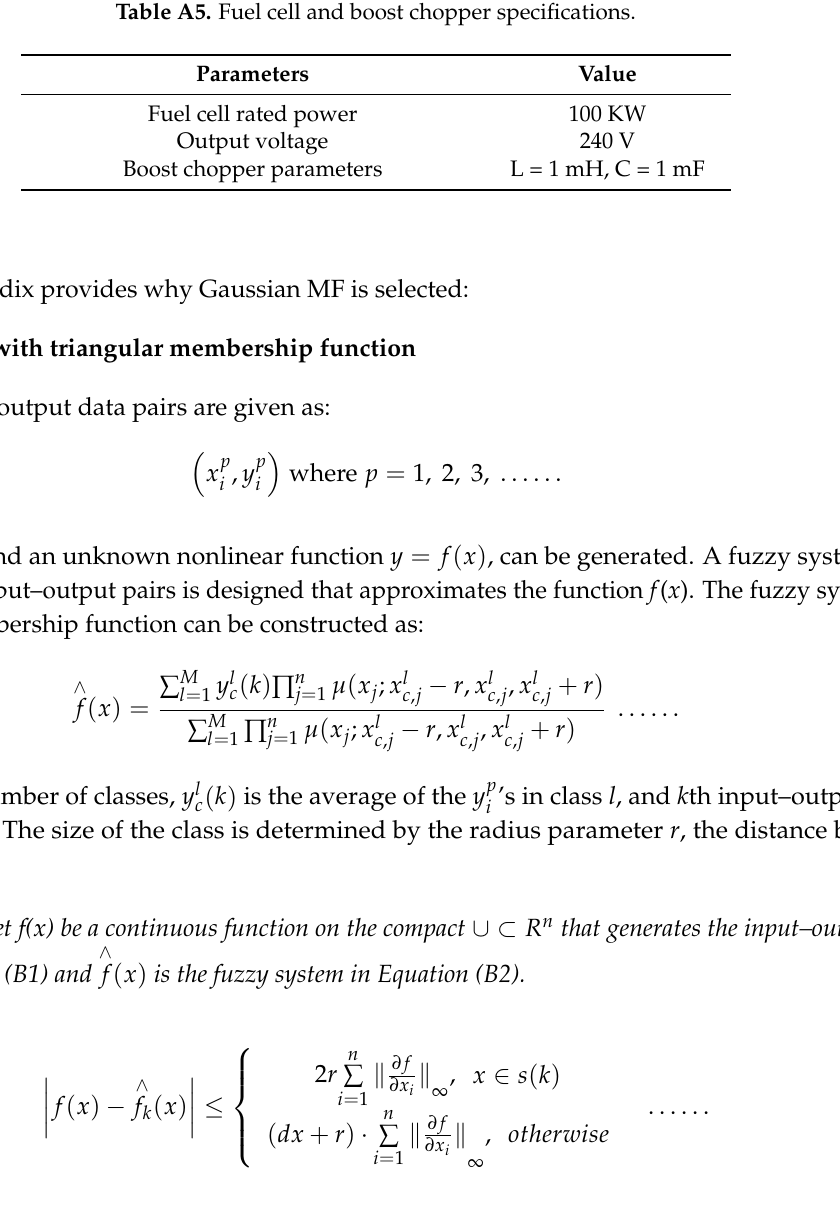
Table A5. Fuel cell and boost chopper